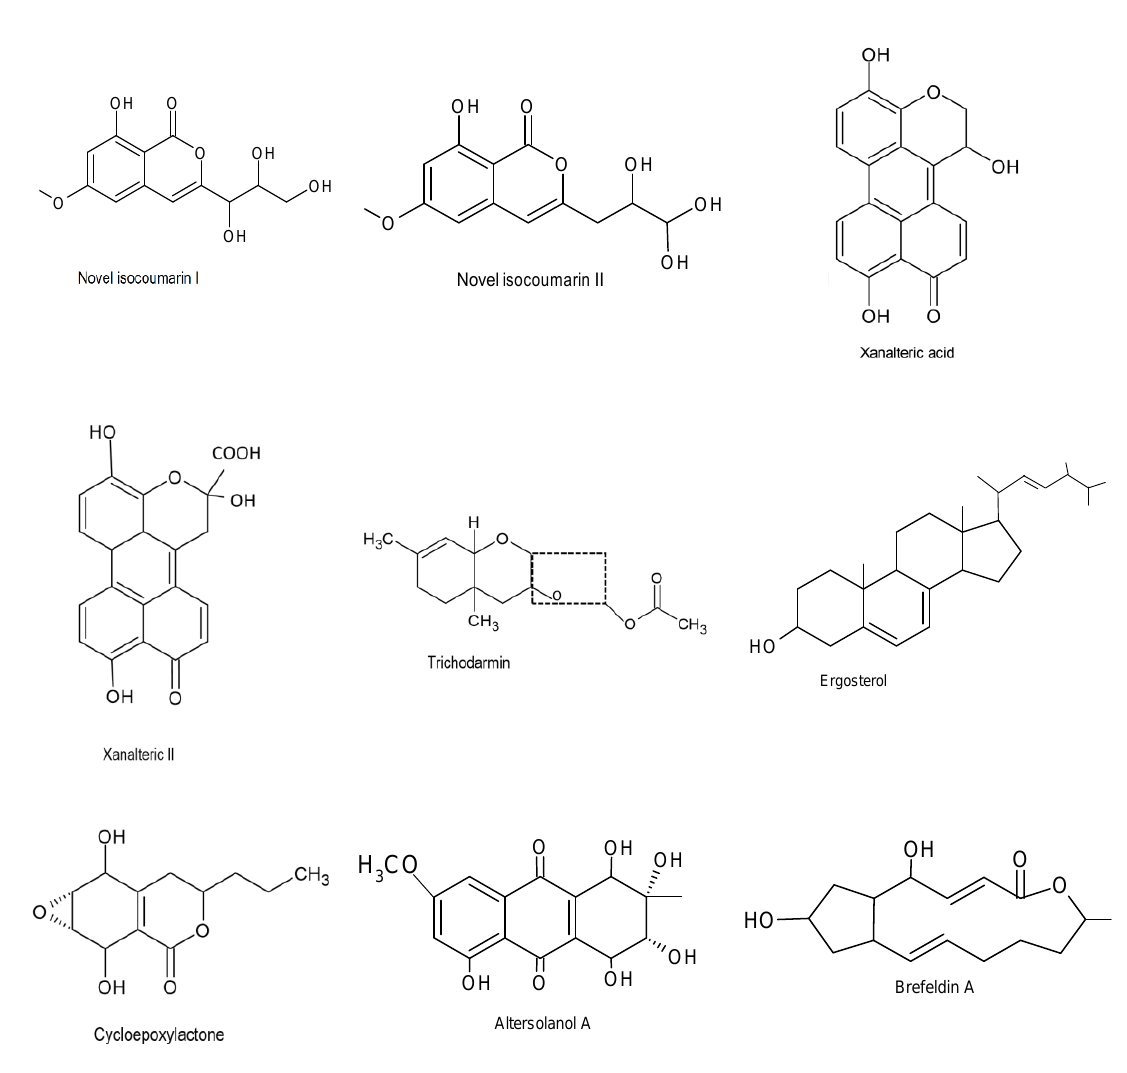
Figure 2. Chemical structures of the bioactive compounds with antibacterial activities [32,33].